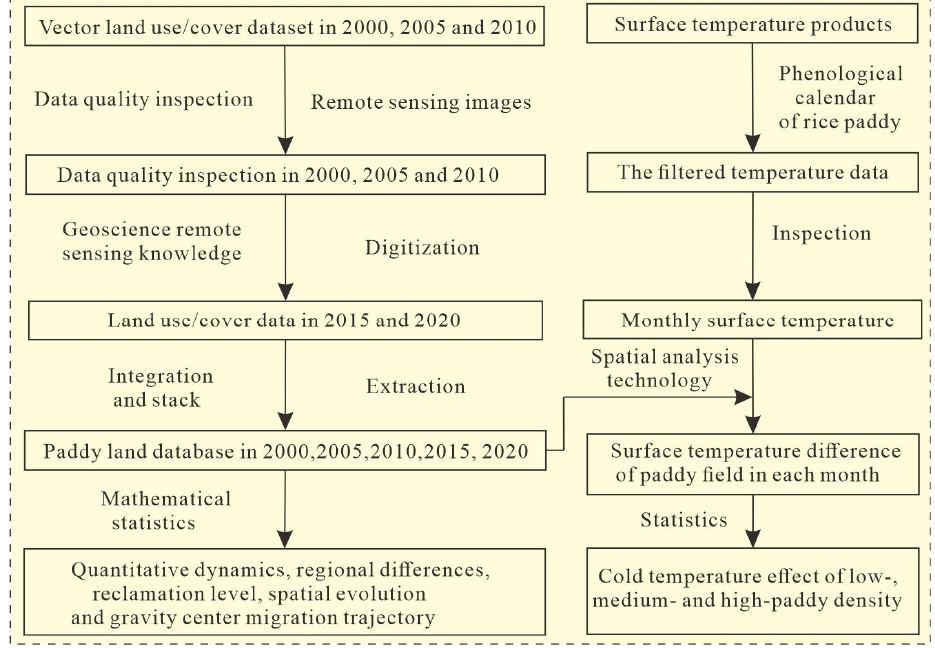
Figure 2. The mainly technical process of spatiotemporal monitoring of paddy field and its impact on surface temperature from 2000 to 2020. on surface temperature from 2000 to